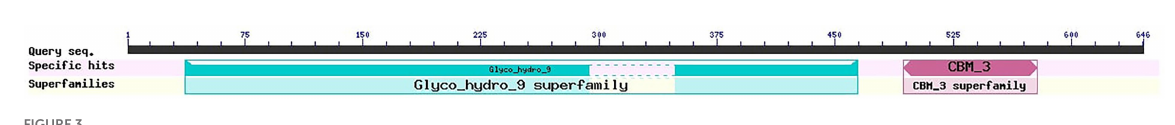
FIGURE 3 The conserved domain prediction in the protein sequence of GH9 β -1,4-glucanase using the NCBI database.